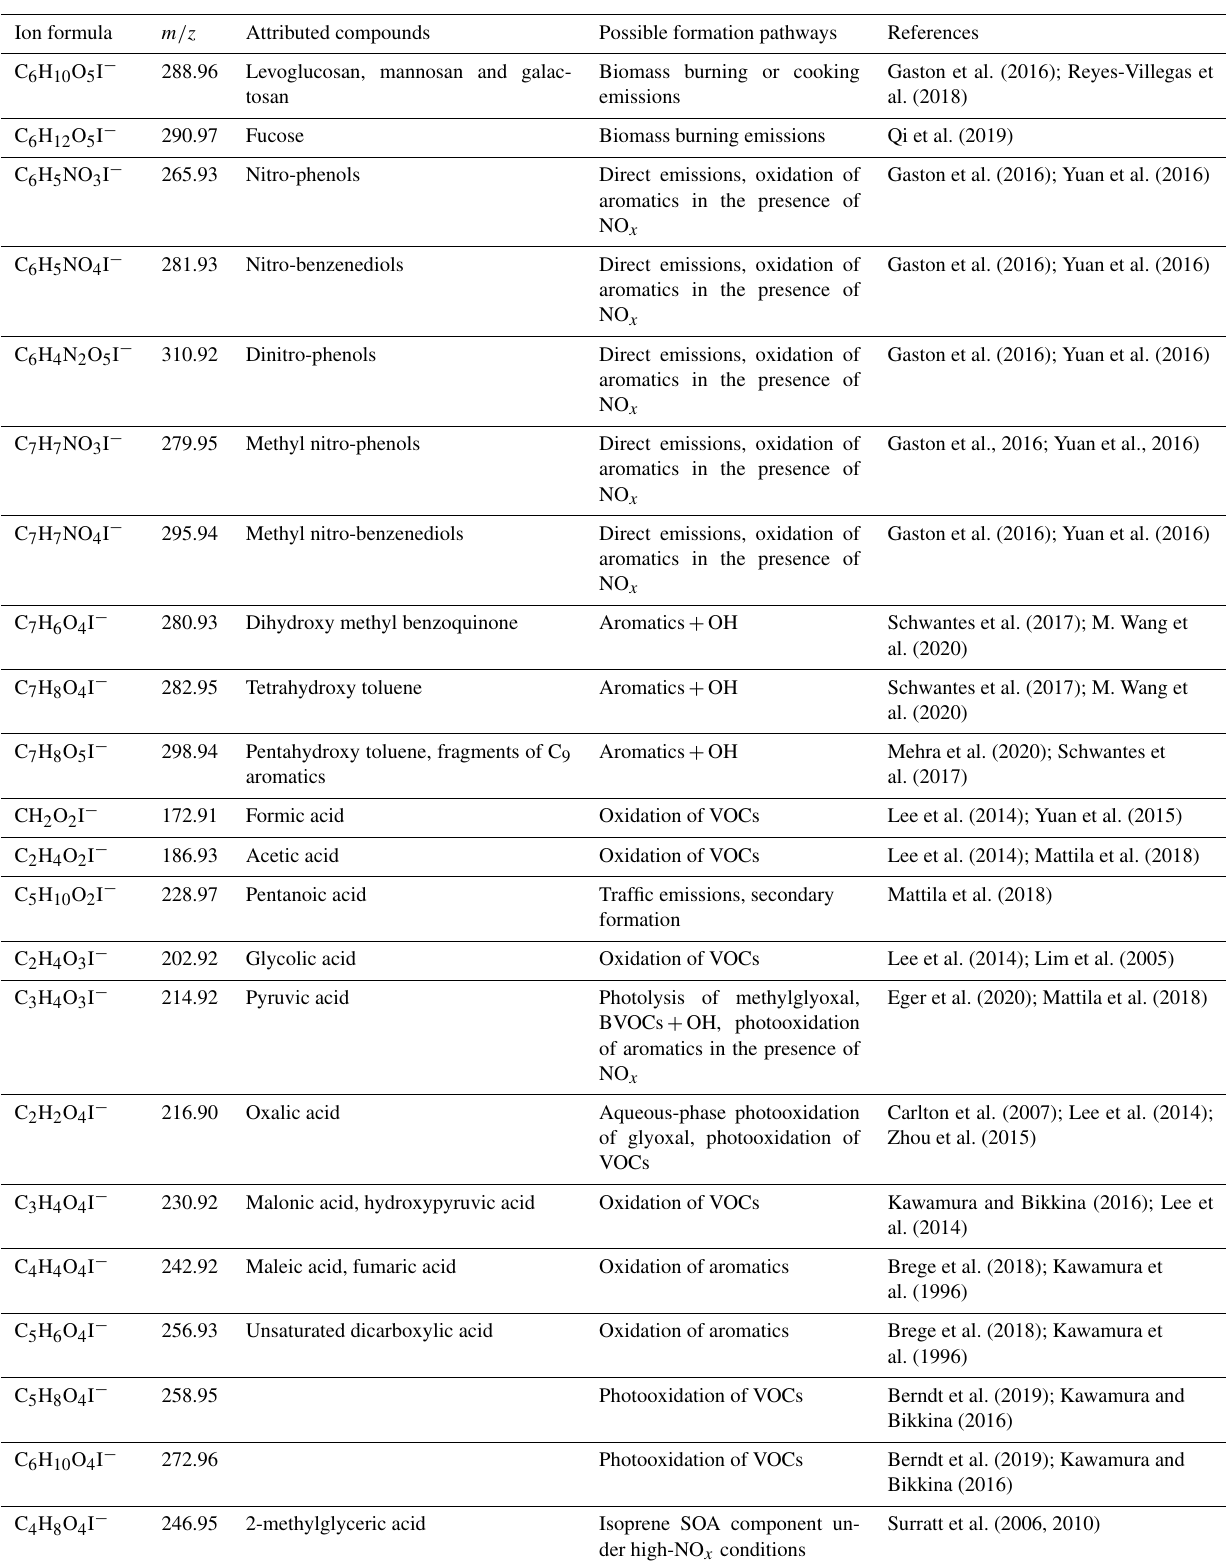
Table 1. The detected ions discussed in the